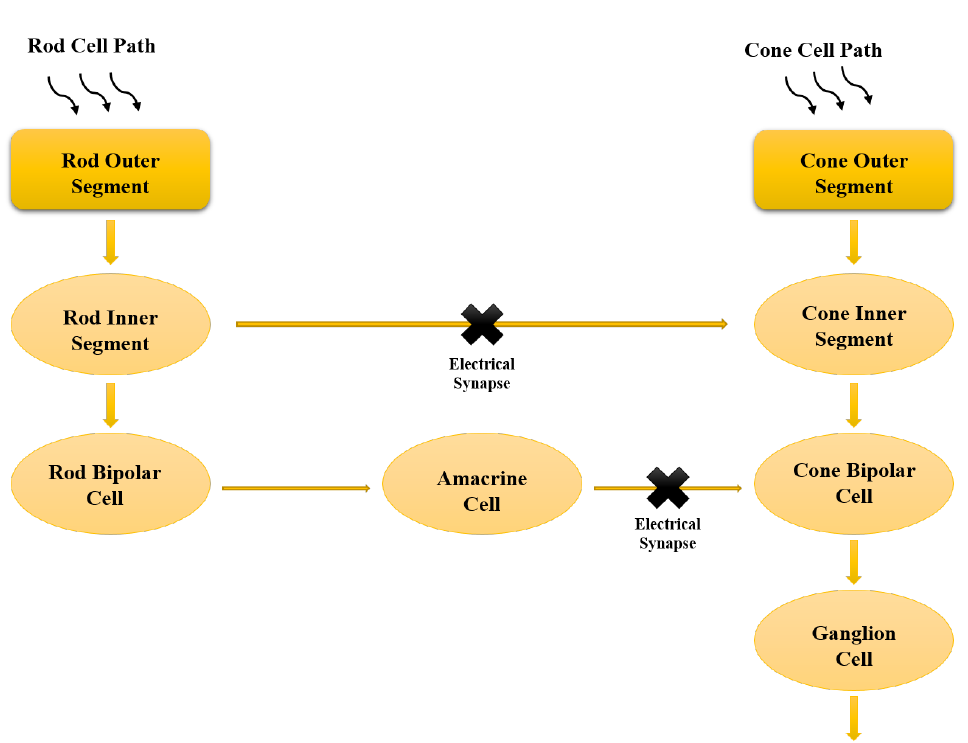
Figure 1. Schematic representation of the bio-flow from photocurrent progression to the ganglion exit. The dual rod and cone pathways are mapping, in which the light signals are transformed into electrical signals that flow from the rod and cone cells through the individual pathways until these signals are integrated into the ganglion cells. Modified after Eshraghian et al. [35].